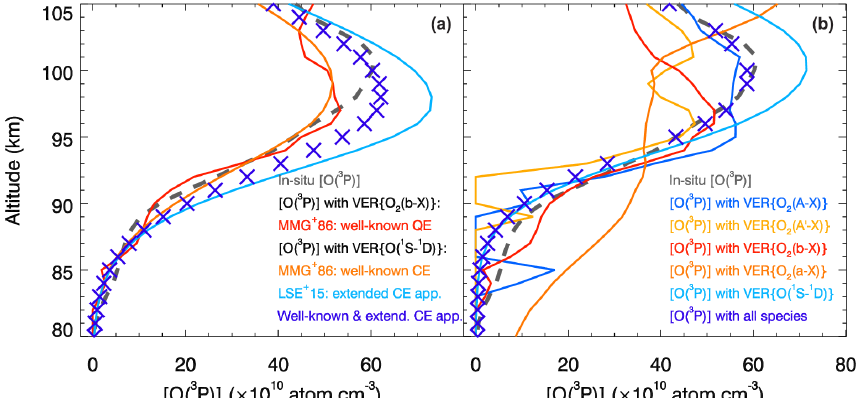
Figure 4. The in situ and retrieved [ O ( 3 P) ] profiles are shown and compared with each other. The in situ [ O ( 3 P) ] profile obtained during the ETON campaign (see Sect. 2) is shown by the dashed gray line to validate [ O ( 3 P) ] retrievals. The well-known quadratic equation (QE) and the well-known cubic equation (CE) of McDade et al. (1986) (MMG + 86) as well as the extended CE of Lednyts’kyy et al. (2015) (LSE + 15) were applied to retrieve the [ O ( 3 P) ] profiles shown in panel (a) . [ O ( 3 P) ] profiles retrieved according to the cubic equations seem to represent two profiles of extreme values with respect to the in situ [ O ( 3 P) ] profile. Therefore, they were arithmetically averaged (see the violet crosses in panel a of this figure) and seem to be in good agreement with the in situ [ O ( 3 P) ] profile values. This was done to estimate the efficiency of the known photochemical models, but we do not ascribe any deeper significance to this finding. Empirical coefficients were introduced in both cubic equations phenomenologically, which stimulated the proposal of the MAC model. The MAC model involving O 2 (A) and O 2 (A (cid:48) ) (see Sect. 3.3) was applied at the retrieval steps provided in Table 12 and consequently applied to retrieve the [ O ( 3 P) ] profiles shown in panel (b) by the solid colored lines similar to Fig. 3. Although steps 2.1, 2.2, 2.3 and 3.2 applied on the basis of some ETON VER profiles result in lower [ O ( 3 P) ] values compared to the in situ ones, the [ O ( 3 P) ] retrieval carried out at step 4.1 on the basis of VER { O ( 1 S − 1 D) } results in higher values. The last retrieval step 5.1 applied on the basis of the concentrations of all chemical species retrieved at the previous steps results in [ O ( 3 P) ] values being in good agreement with the in situ